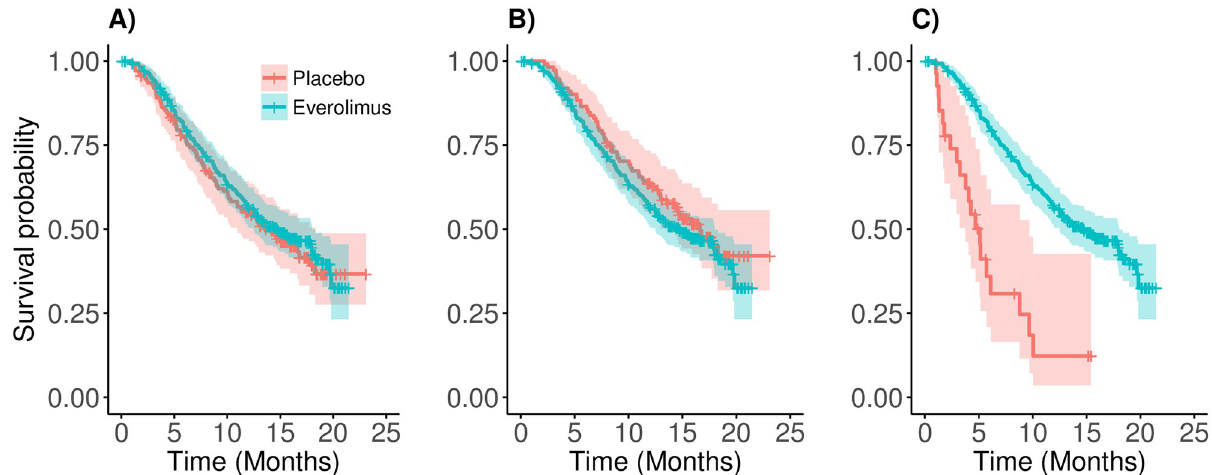
Fig 1. Kaplan-Meier curves from the ITT analysis including all patients (image A), with only treatment switchers in the placebo arm (image B), and with only non-switchers in the placebo arm (image C). Sample size in the placebo arm is equal to 139, 111 and 28 patients in plots A, B and C, respectively. Sample size in the Everolimus arm is equal to 277 patients in all